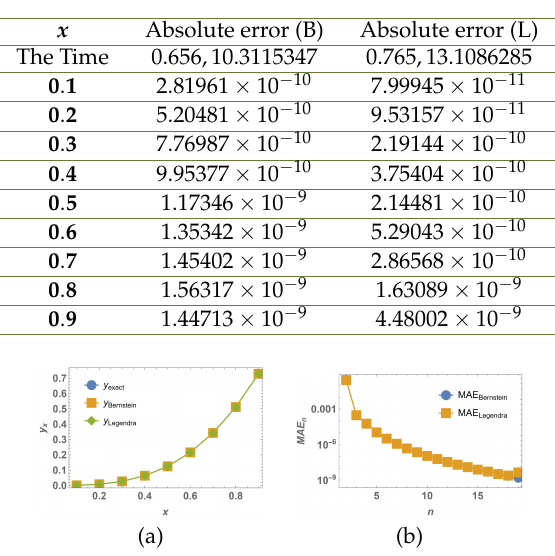
Table 2. The absolute error ((BOM, LOM)) methods for example 2 at n=19